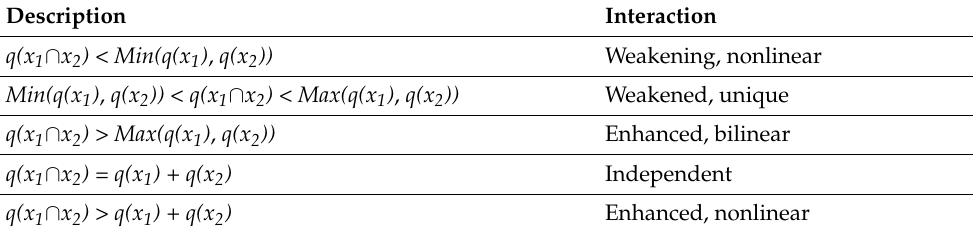
Table 2. Defined interaction relationships